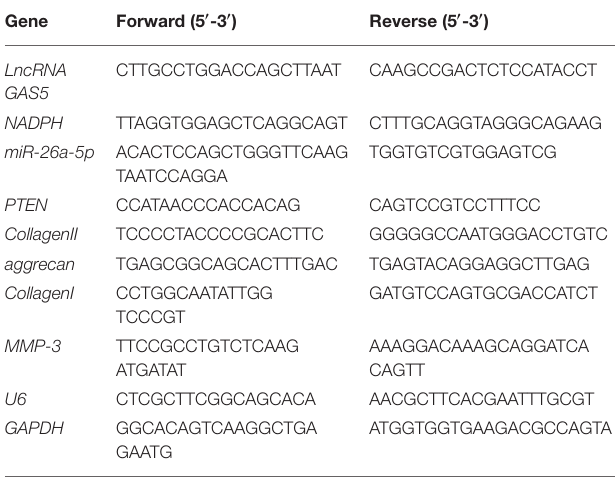
TABLE 1 | Primer sequences of RT-qPCR.